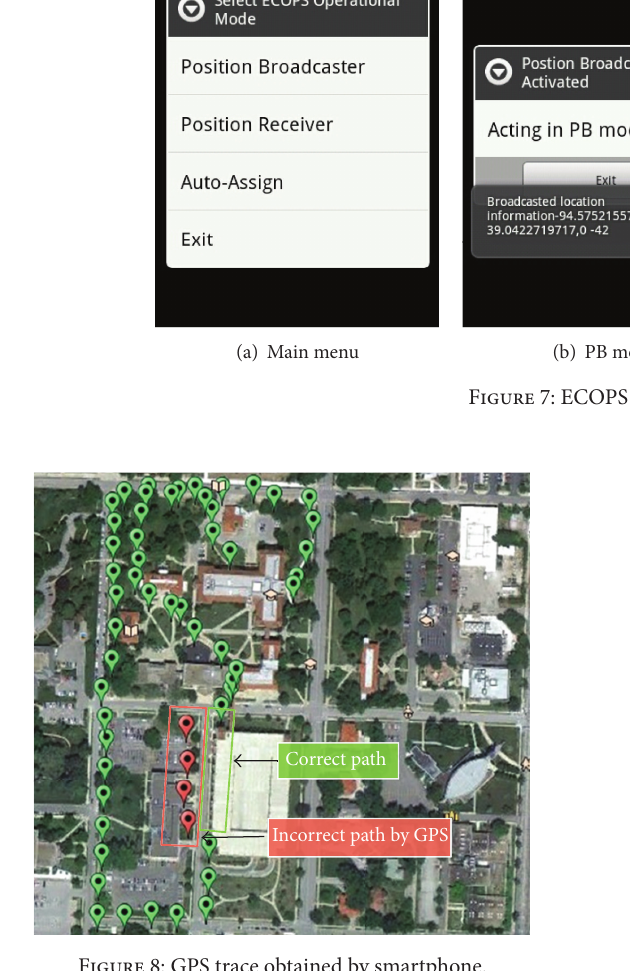
Figure 8: GPS trace obtained by smartphone.